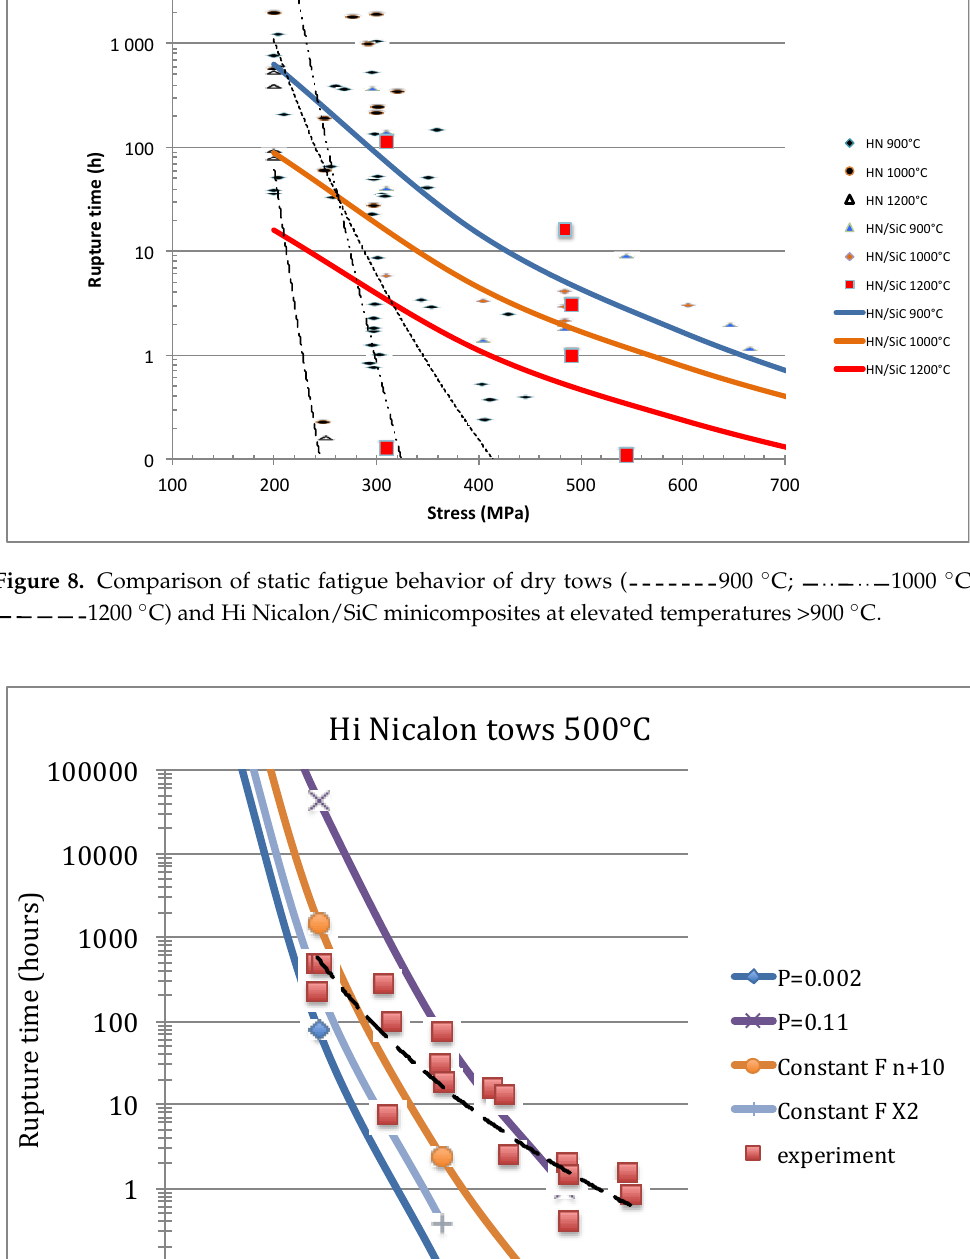
Table 4. Estimates of stress exponent p and constant A at temperatures for Hi Nicalon fiber tows [16,20].